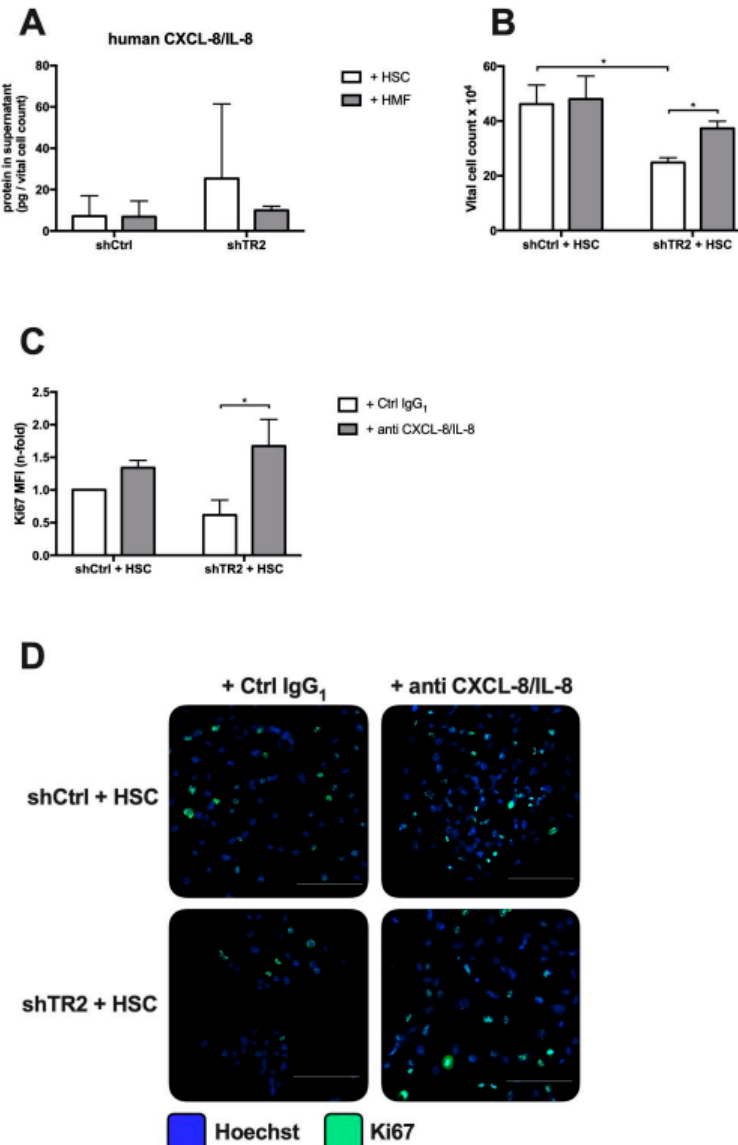
Figure 7. HSC-mediated growth suppression of PancTu-I shTR2 cells is CXCL-8 / IL-8 dependent. Supernatants of PancTu-I shCtrl and PancTu-I shTR2 cells cocultured with HSC or HMF were analyzed for humanCXCL-8 / IL-8levelsbyLEGENDplex multiplexanalysis. ( A )DetectedCXCL-8 / IL-8concentrations were normalized to vital cell counts of corresponding PancTu-I cells. For blocking experiments, PancTu-I shCtrl and PancTu-I shTR2 cells were indirectly cocultured in the presence of HSC and treated with either 10 µ g / mL control IgG1 or anti-CXCL-8 / IL-8 antibody. After 6 days of coculture, ( B ) vital cell count and ( C ) the proportion of Ki67 + cells were determined. The percentage of proliferating cells was determined by immunofluorescence Ki67-Alexa-488 staining. Data are normalized to control group shCtrl + HSC + control IgG1. ( D ) Representative images of immunofluorescence Ki67 staining are shown. Scale Bars 100 µ m. Data represent the mean ± SEM of 4–5 independent experiments; * = p <